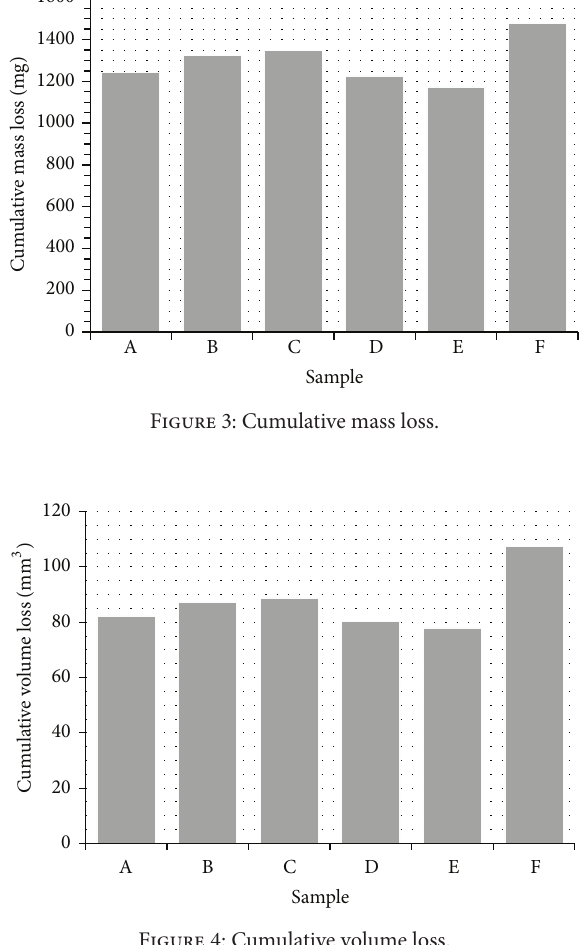
Figure 4: Cumulative volume loss.